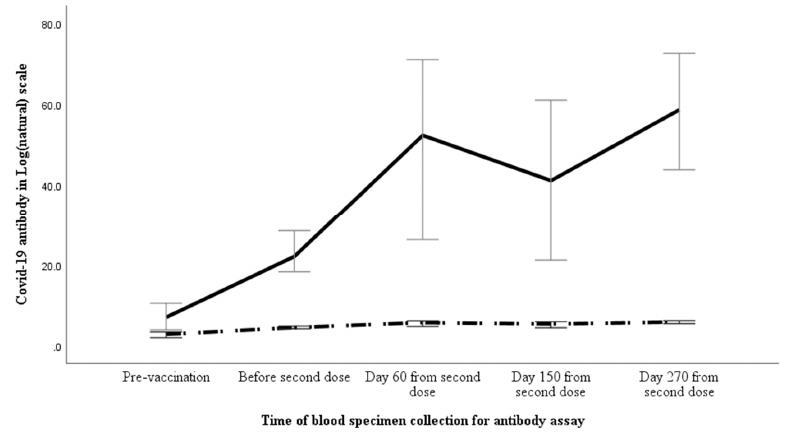
Figure 2. Temporal pattern of anti-spike antibody (solid line) and percentage of neutralising antibody (broken line) in study participants. The ASAb and NAb results along with 95% error bar are shown in Log (natural) scale along the Y axis, whereas X axis shows the time of specimen collection. We compared the ASAb and NAb response of the participants with or without de- tectable ASAb before vaccination (Table 3). As compared to those without pre-existing ASAb, significantly higher ASAb titres were achieved in those with pre-existing ASAb at day 28 ( p < 0.001), day 60 ( p = 0.007) and day 150 ( p < 0.001) but their levels were compa- rable at day 270 ( p = 0.333) after second dose (Figure 3a). The NAb percentages were sig- nificantly higher at day 28 ( p < 0.001) but were comparable at day 60 ( p = 0.255), day 150 ( p = 0.155) and day 270 ( p = 0.626) (Figure 3b). Table 3. Comparison of COVID-19 antibody response between those with or without pre-existing anti-spike antibody before vaccination in overall cohort (n = 135).